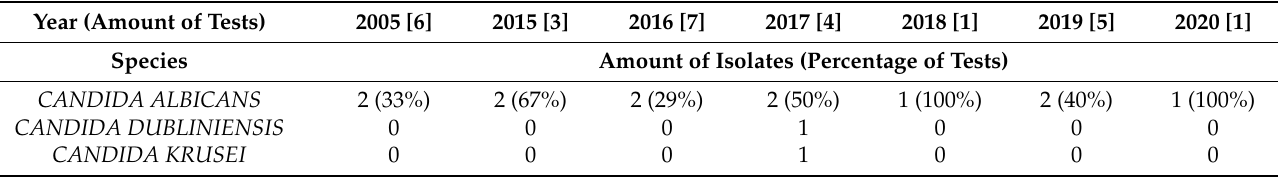
Table 3. Yeast species isolated from the upper respiratory tract samples from PCICU each